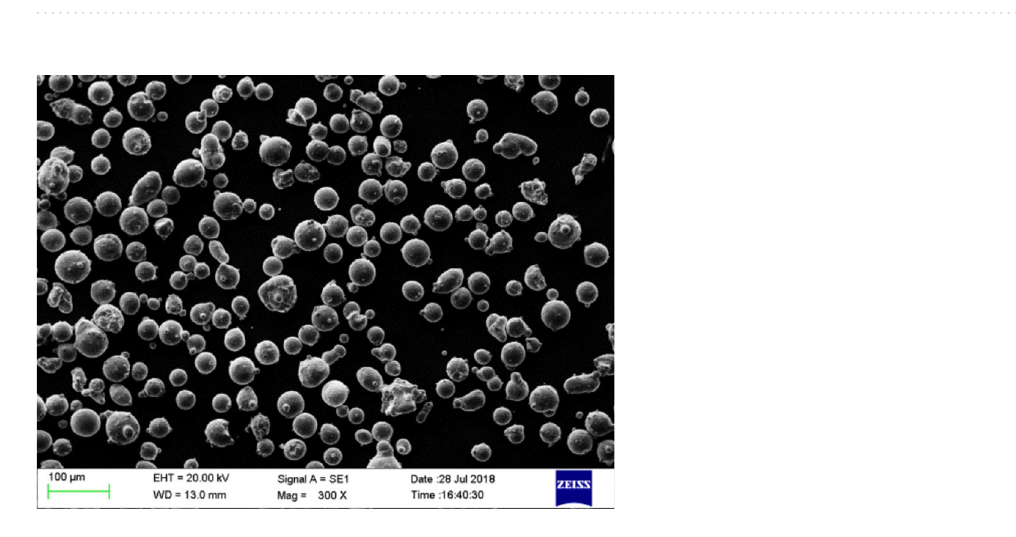
Figure 1. LPBF equipment.